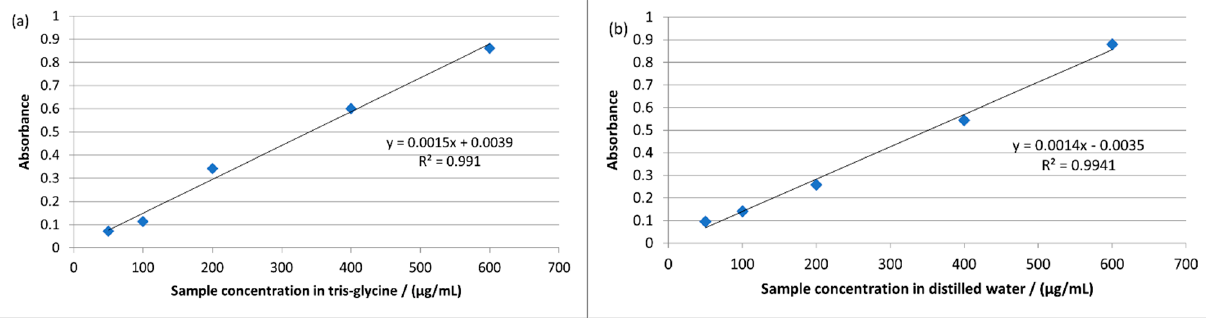
Figure 1. The calibration curves in ( a ) tris-glycine and ( b ) distilled water.